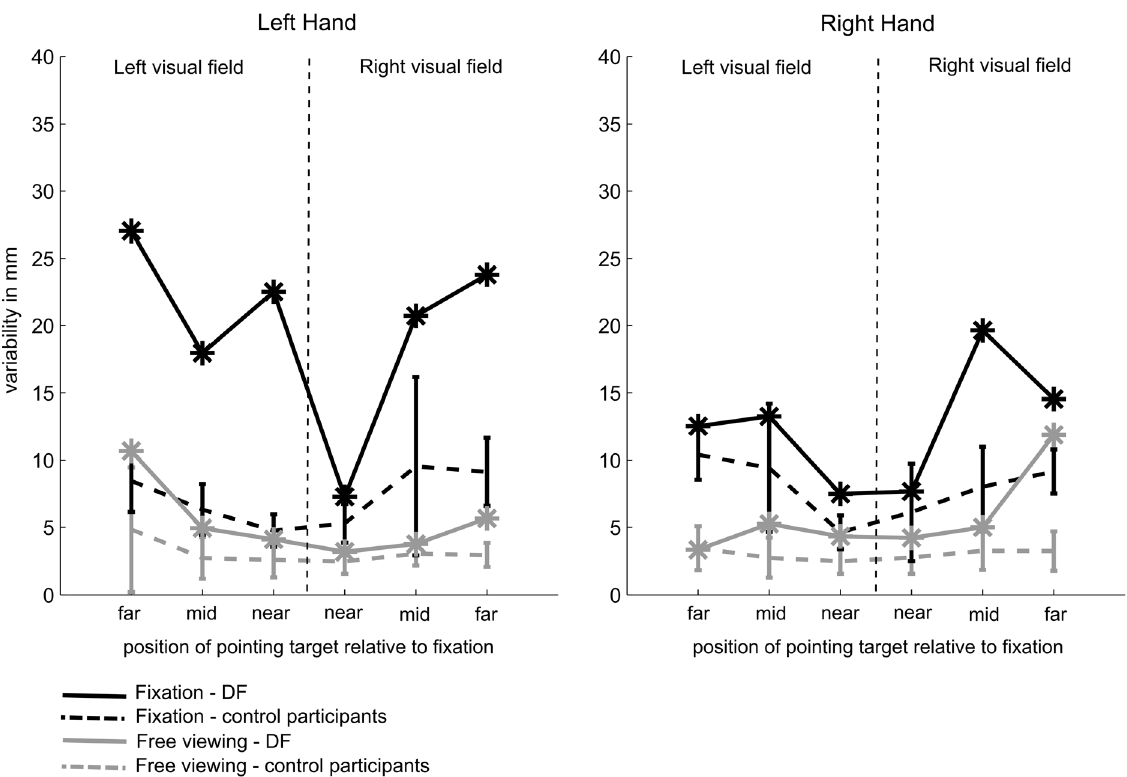
Figure 3. Average 2D-pointing-variability as a function of target eccentricity and visual field. Pointing variability is depicted separately for pointing movements performed with the left hand (left panel) and movements performed with the right hand (right panel). Grey lines represent movements executed in the free-viewing conditions and black lines represent movements executed in the fixation conditions. The performance of the control participants is represented as dashed lines and DF’s performance as solid lines. Error bars depict the sample standard deviation.